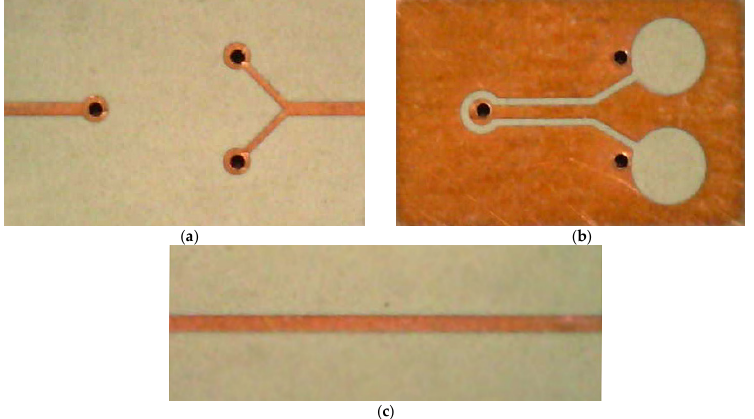
Figure 5. Fabricated UWB phase inverter: ( a ) top view, ( b ) bottom view, ( c ) top view of the reference microstrip line. The dimensions are 290 mil × 200 mil (7.36 mm × 5.08 mm).